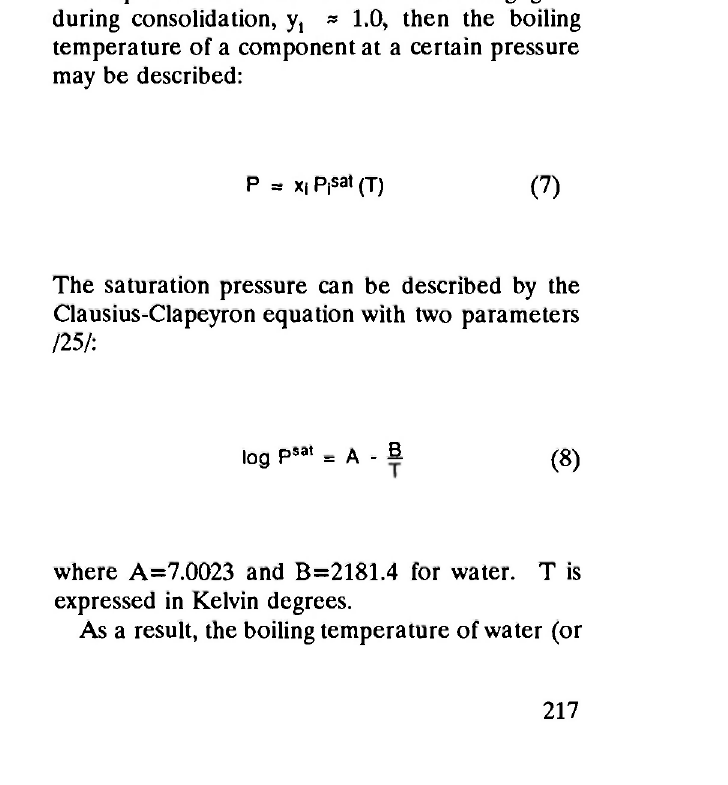
Fig. 6: Degree of conversion prediction of SC- 1008 phenolic resin as a function of processing time for the proposed curing